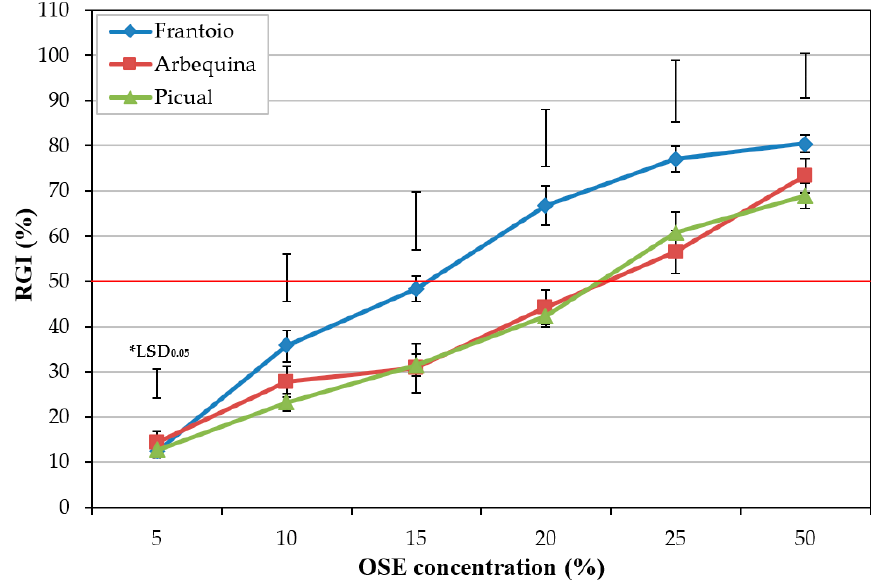
Figure 1. Effect of olive stem extract (OSE) from healthy olive plants of cvs. Frantoio (tolerant), Arbequina (moderately susceptible), and Picual (highly susceptible) on relative conidial germination inhibition (RGI) of Verticillium dahliae isolate V180. Data are the means of 240 conidia (six replicates) per combination of olive cultivar and OSE concentration. Vertical bars represent the standard error of the means. *LSD bars represent the critical values for comparison at P = 0.05.